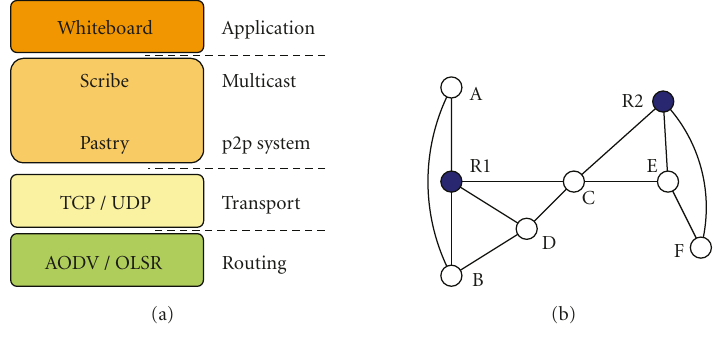
Figure 1: (a) Protocol stack and (b) network topology of our